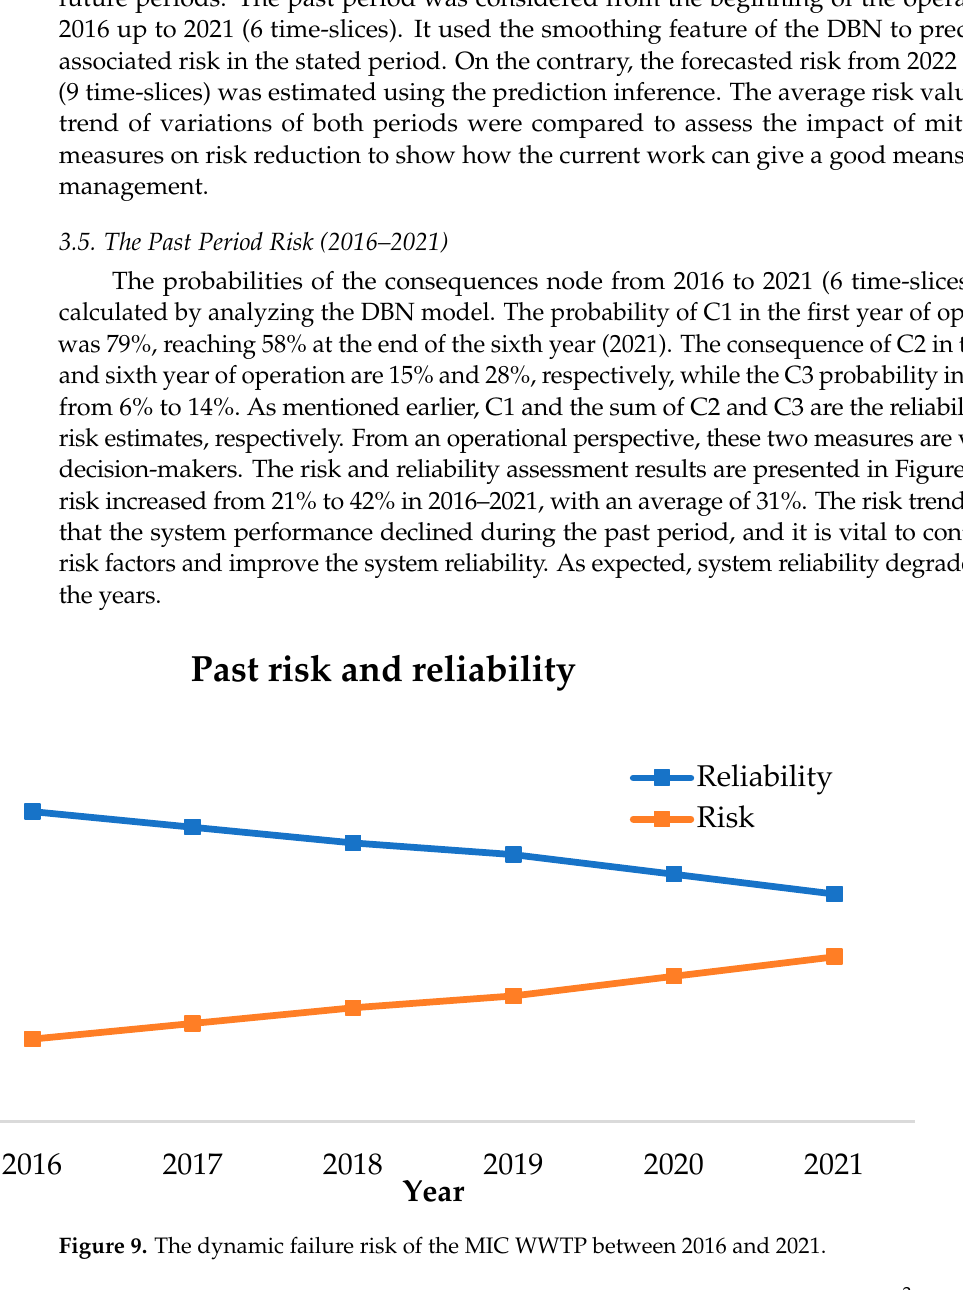
Table 4. WWTP parameters with removal rate for 2016 and 2021.